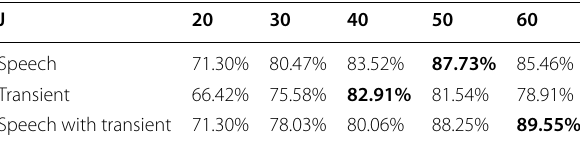
Table 1 The accuracy of the proposed algorithm in different context window